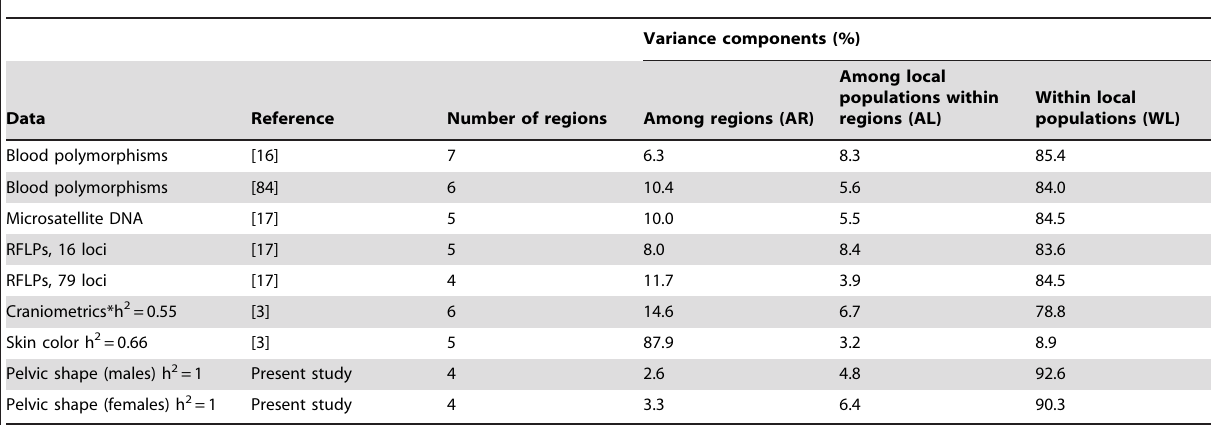
Table 4. Apportionment of genetic and phenotypic